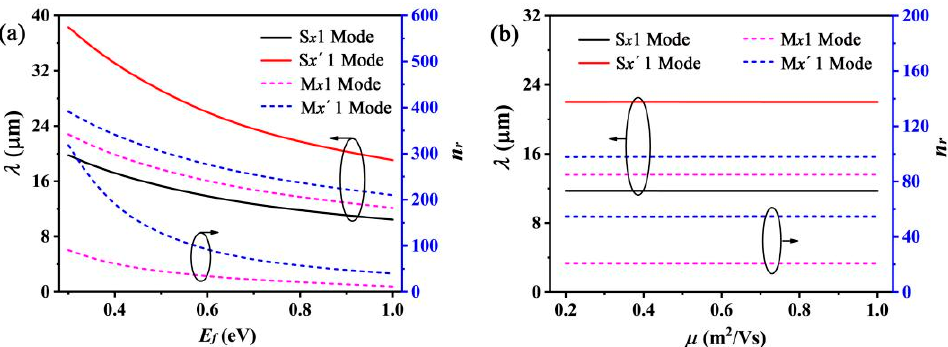
Figure 5. ( a ) Resonant wavelength and effective index as a function of E f for different modes. ( b ) Resonant wavelength and effective index as a function of μ for different modes.